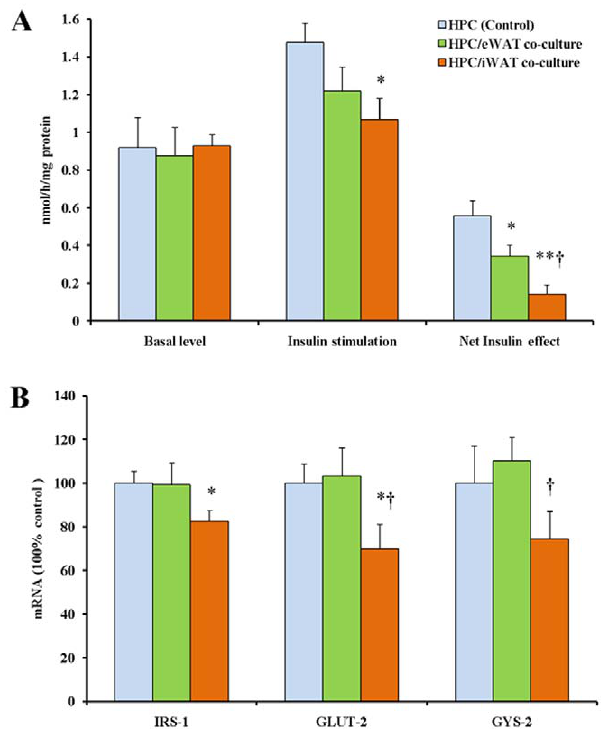
Figure 6. Insulin resistance properties of rat hepatocytes (HPC) co-cultured with adipose tissue explants from epididymal adipose tissue (eWAT) and inguinal adipose tissue (iWAT). A: Incorporation of [U- 14 C]glucose into glycogen in HPCs with the presence of insulin. B: Expression levels of genes regarding cellular glucose uptake and glycogen synthesis in HPCs. b -actin was used as a reference gene. * and **, P , 0.05 and P , 0.01 vs control value, respectively. { , P , 0.05 vs eWAT co-culture group